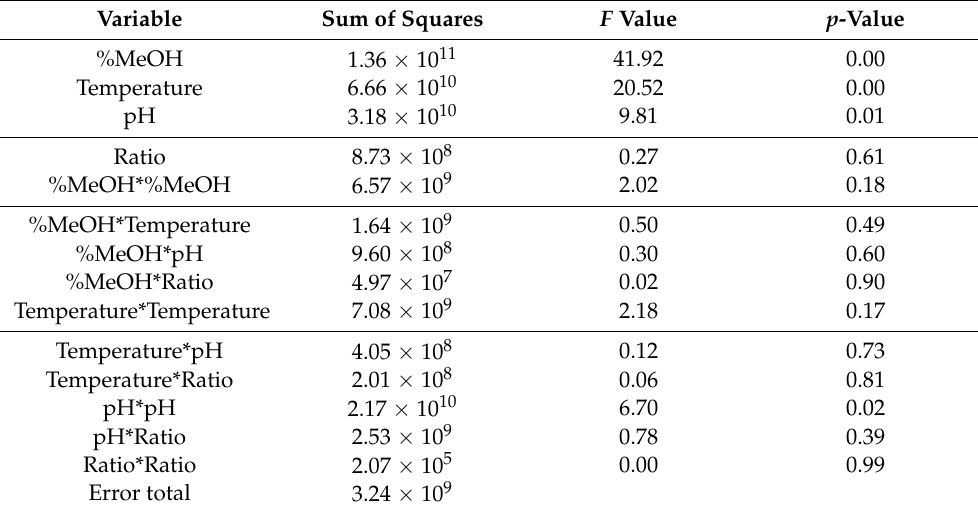
Table 2. Results from the BBD-RSM analysis on the anthocyanins obtained from purple potato samples.